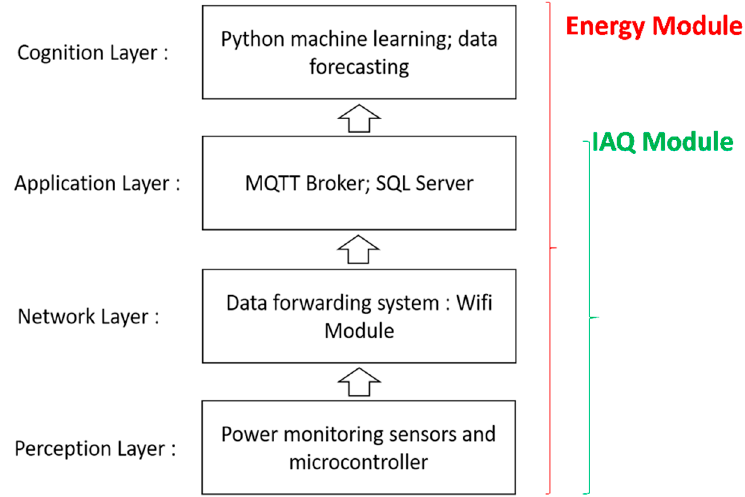
Figure 3. System structure of the system: modularity implementation of the technologies monitoring energy parameters and indoor air quality.